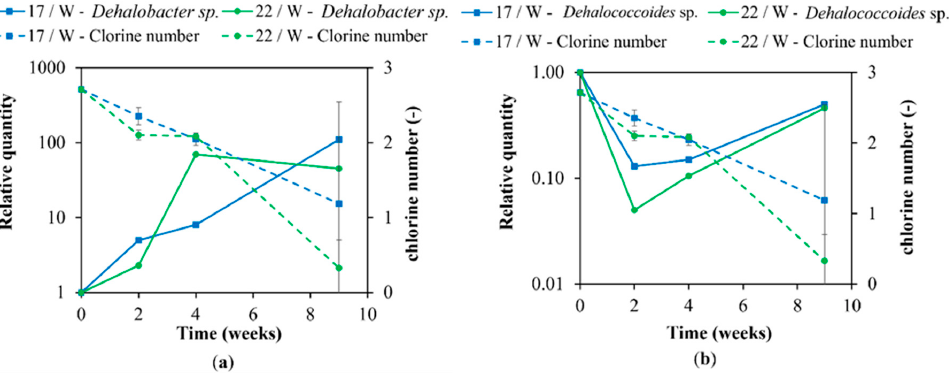
Figure 8. Correlation between ( a ) Dehalobacter sp. and ( b ) Dehalococcoides sp. and chlorine number at 17 and 22 ◦ C with the addition of